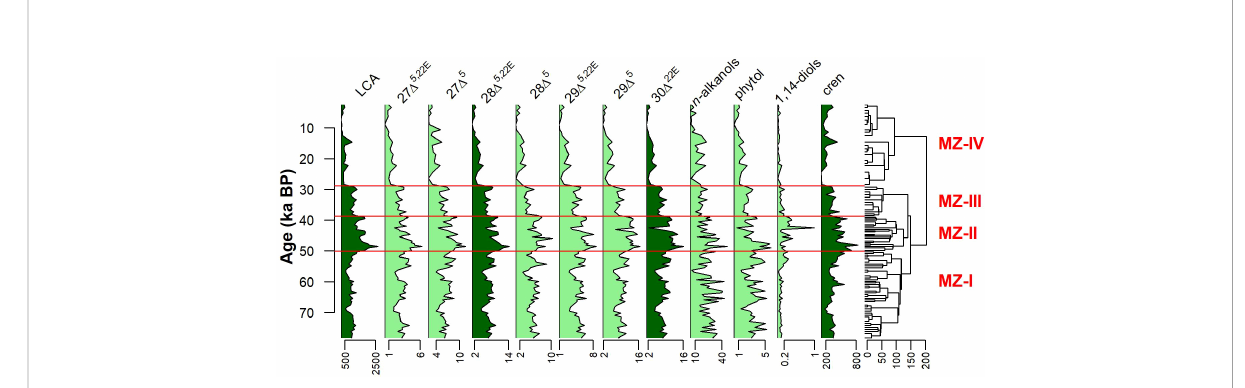
FIGURE 4 Summary diagram showing the mass accumulation rates (in ng cm − 2 year − 1 ) of the organic molecular markers associated with marine organic matter, the constrained dendrogram, and the MZs for core NAP 63-1. Proxies colored with dark green will be discussed in more detail.